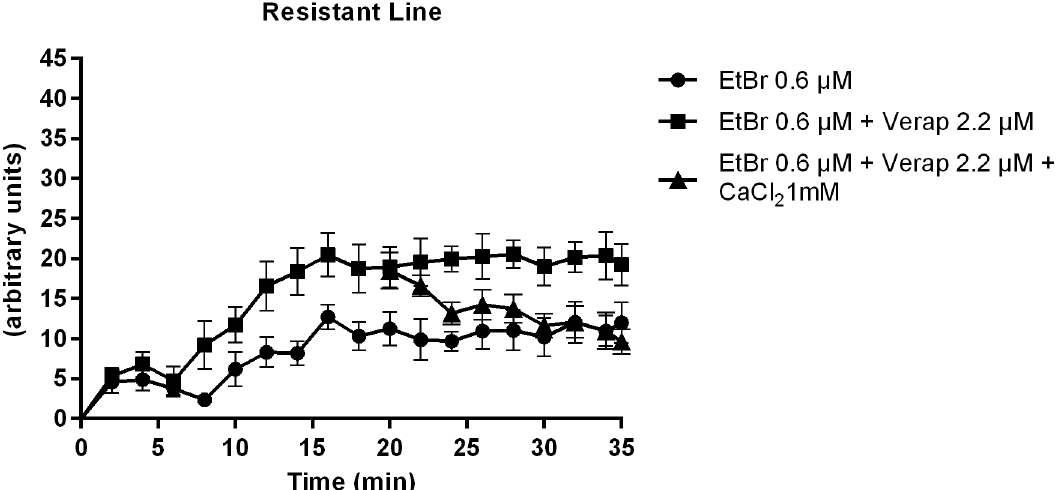
applied for the construction of mortality trend curves to get a better view of Verapamil effect on their susceptibility to PZQ (Fig 9). A decrease in the PZQ concentration required to achieve the same level of mortality was evident once compared to parasites not exposed to the inhibitor.